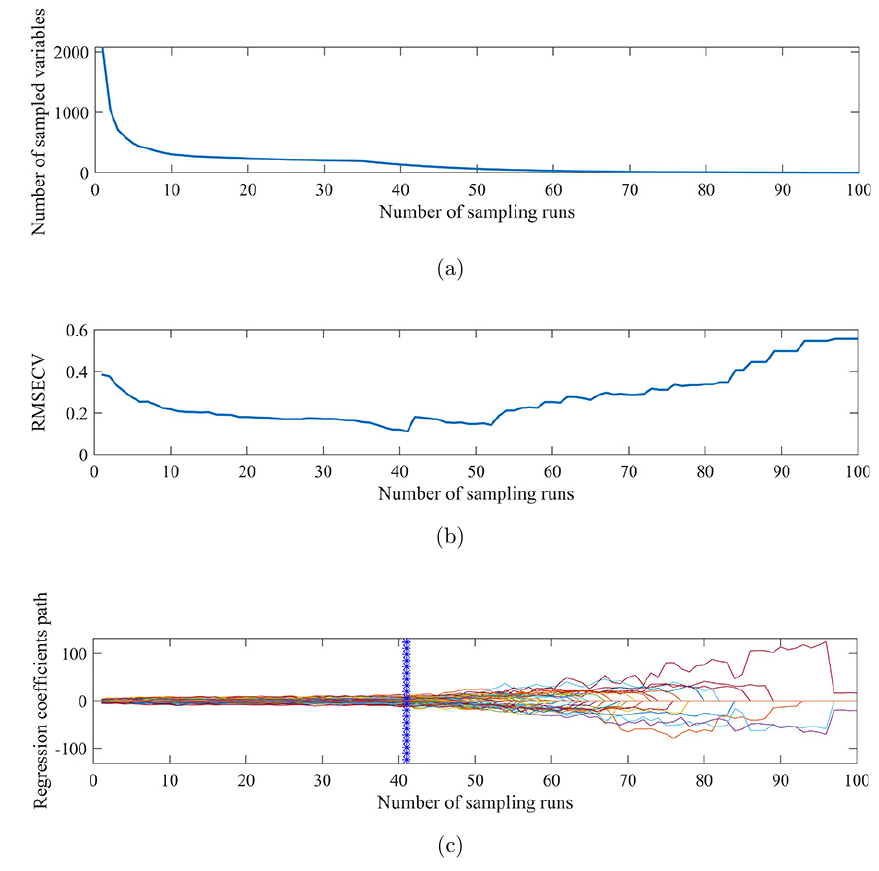
Fig. 5. CARS variable selection on spectra data of CR dataset.